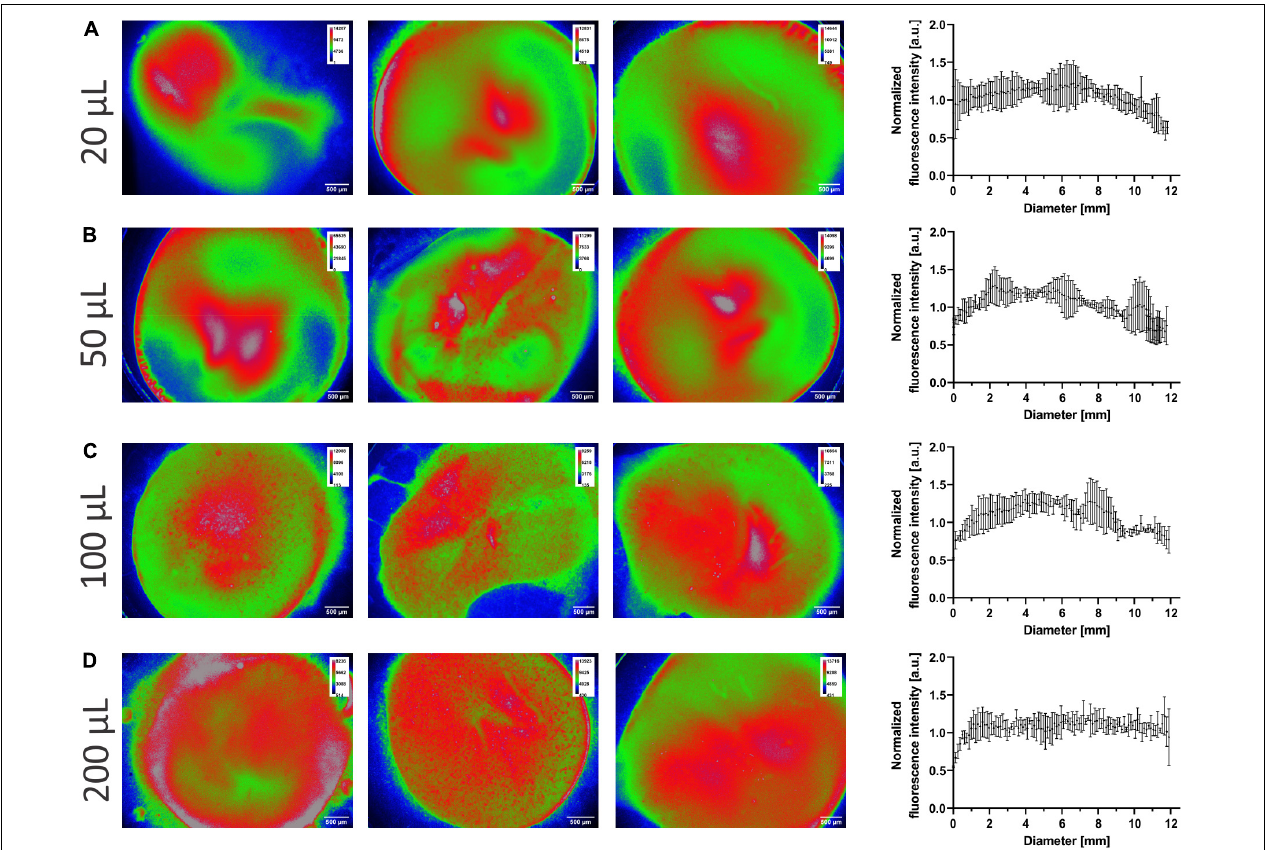
FIGURE 6 | Homogeneity of deposition. Sodium fluorescein-liquid crystalline nanoparticles (LCNPs) were nebulized onto Transwell R (cid:13) insert membranes as described in the section “Materials and Methods.” (A–D) Representative fluorescent micrographs of the membranes (from the bottom up), where the highest fluorescence intensities are color-coded as red and the lowest as blue. The fluorescence intensities per pixel were extracted across the center of the membrane. The individual intensities (correlated to the mean intensity) were normalized to arbitrary 1 and plotted against the diameter of the membrane. N = 3, data are reported as mean with standard deviation, where every 25th data point is shown for clarity. a.u, Arbitrary